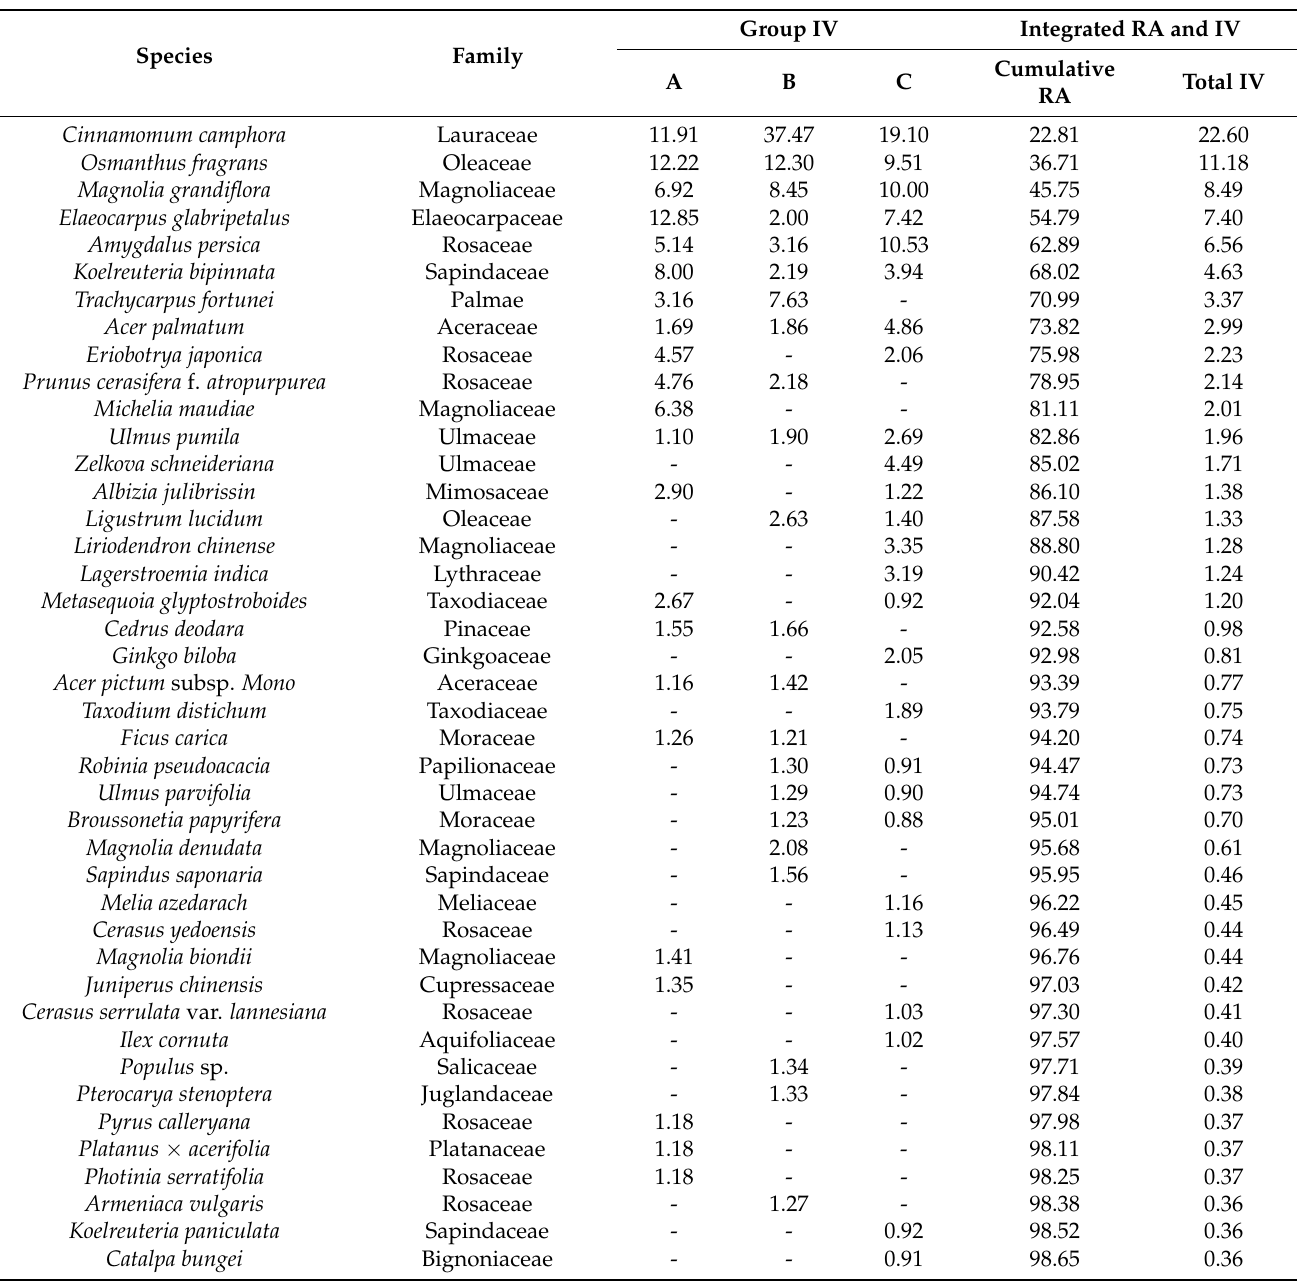
Table 2. Cumulative relative abundance (RA) and importance value (IV) of individual species by three RRA groups and all sampled plots of resettlement residential areas in